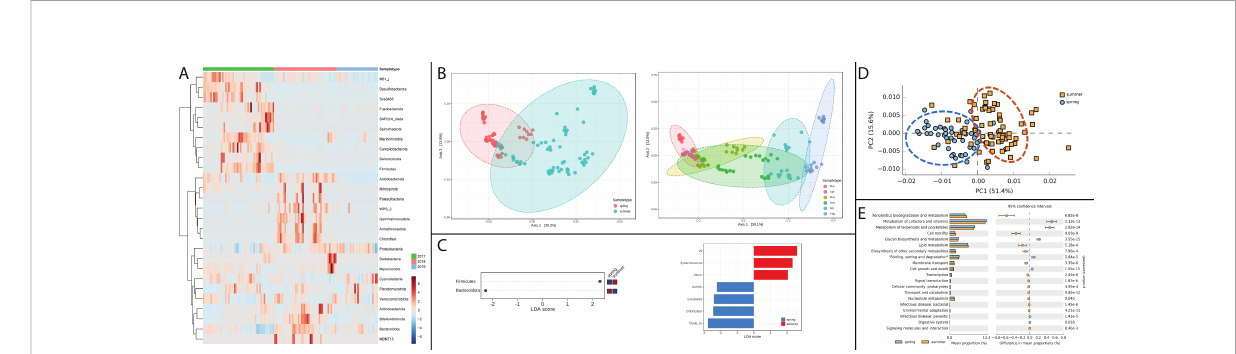
FIGURE 3 Temporal variation of bacterial community and function in shell fi sh farming areas. (A) Annual abundance heatmap at phylum level; (B) Seasonal (left) and monthly (right) variation of alpha diversity; (C) Discriminative features of bacterial community at phylum level (left) and genus level (right); (D) Principal components analysis (PCA) of bacterial functional characterization; (E) The functional pathways in signi fi cantly temporal variation patterns.